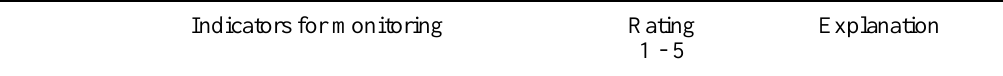
Table 2 . Key variables and outcome indicators for collaborative monitoring. Each indicator was rated according to a 5 point scale (5 = strongly agree; 1 = strongly disagree) and an explanation was provided by participants (Key variables adapted from Lee 1993, Michael 1995, Wenger 2000, Pretty 2003, Olsson et al. 2004 a , Armitage 2005, Brown et al. 2005, Kumler and Lemos